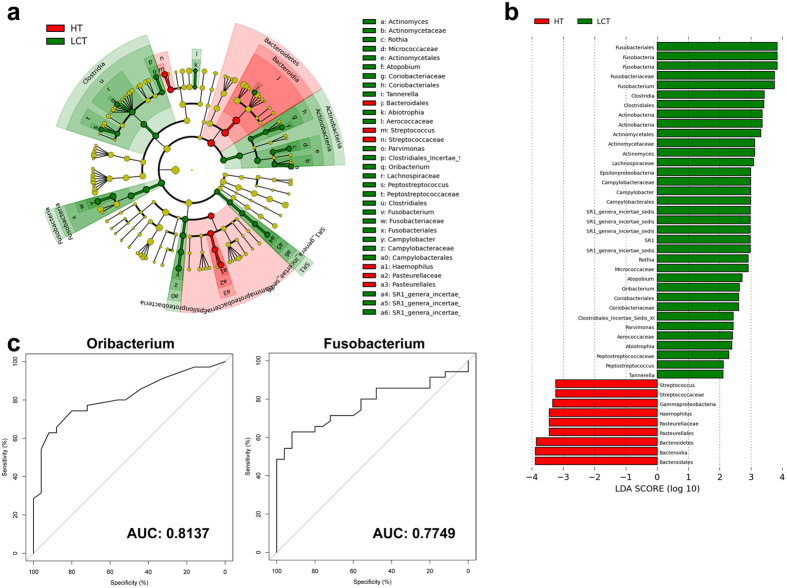
LEfSe and LDA analysis based on OTUs characterize microbiomes between the LCT and HT.(a) Cladogram using LEfSe method indicating the phylogenetic distribution of tongue coat microbes associated with patients with LC (green) and healthy subjects (red); (b) LDA scores showed the significant bacterial difference between the LCT and HT; (c) Prediction of the key genera for LCT from HT; ROC for Oribacterium, AUC = 0.8137; ROC for Fusobacterium, AUC = 0.8137. LCT, liver cancer patients tongue coat; HT, healthy subjects tongue coat.